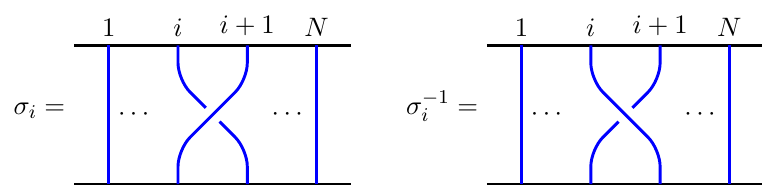
Figure 8 . Pictorial realization of the N -strand braid generators, σ i and σ − 1